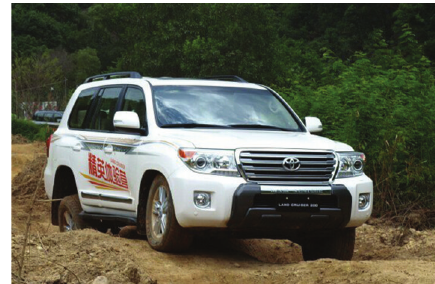
Figure 10: The warp mode excitation.